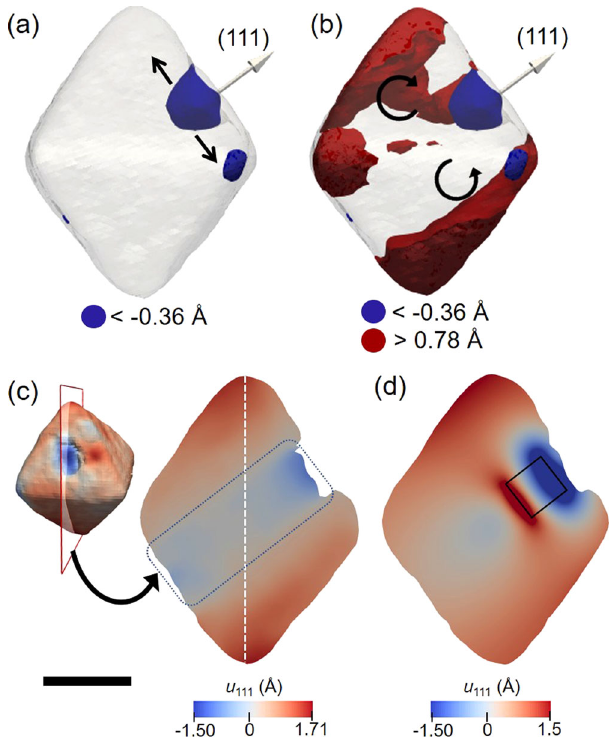
Fig. 2 Displacement fi eld distribution over the Pd nanocrystal for the measurement done under pristine conditions. a Semitransparent 3D plot of the Pd nanoparticle showing negative displacement values (< − 0.36 Å, blue-colored) and ( b ) the same negative values shown in ( a ) and positive displacement values (>0.78 Å, red-colored). c Cross-section view of the internal displacement fi eld distribution taken along the (111) Q vector. The position of the plane taken from the 3D reconstruction is shown in the top- left. d Cross-sectional view of the displacement distribution from the fi nite element analysis, modeled using the original reconstructed octahedral nanoparticle shape with a cube placed inside it to represent the seed nanoparticle. The square inside the plot represents the cube position. The scale bar in ( c ) denotes 100 nm and it is representative for ( a ) – ( d ).